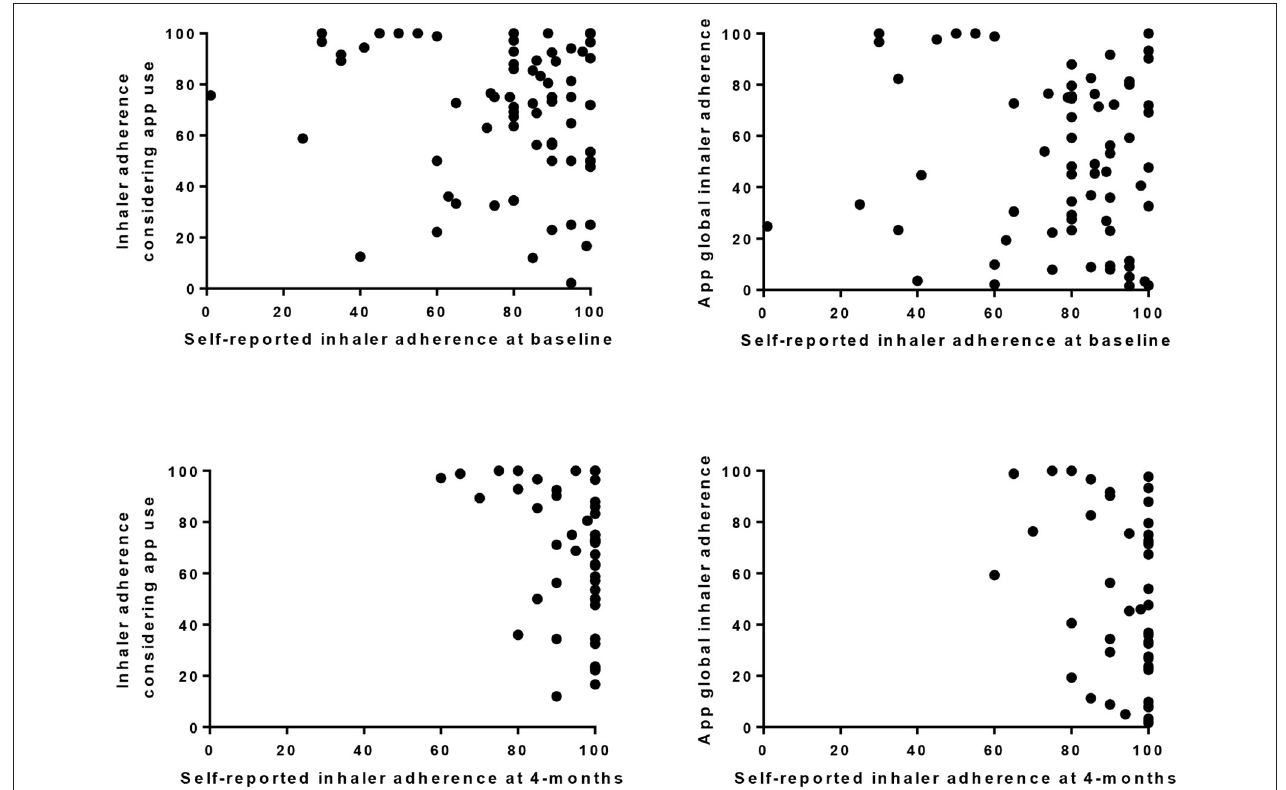
FIGURE 2 | Scatter plots showing the relationship between patients self-reported estimates of inhaler adherence (at baseline n = 69 and 4 month n = 47), and inhaler adherence calculated using app data with two methods: one method considered the medication taken only on days with app use (Inhaler adherence considering app use), and the other method considered the medication taken regardless of app use, i.e., considering all medication scheduled for the 120 days (app global inhaler